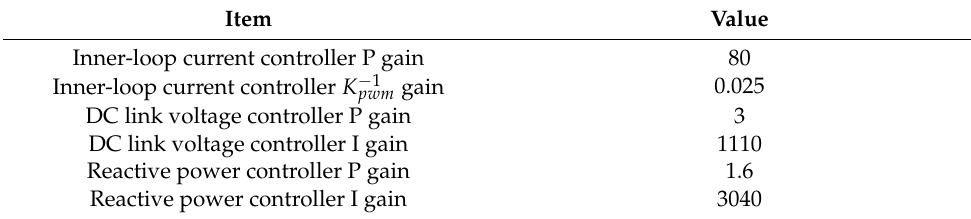
Figure 13. ( a ) Inner-loop current controller of grid inverter; ( b ) simplified outer-loop DC link voltage controller of grid inverter; and ( c ) simplified outer-loop DC link voltage controller of grid inverter. To sum up the design, the results of controller parameters are listed in Table 2. Table 2. Controller parameters of proposed grid inverter